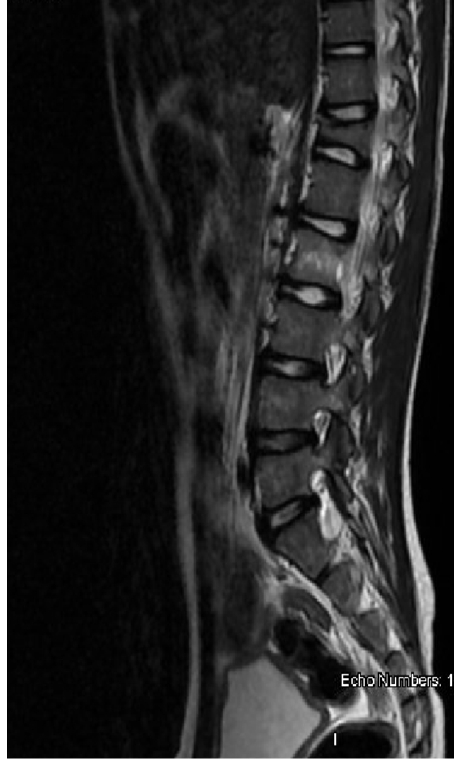
Figure 2. Spine MRI after treatment: complete disappearance of both D12 lesion and tissue proliferation with persistence of mild signal alteration at L2 level.